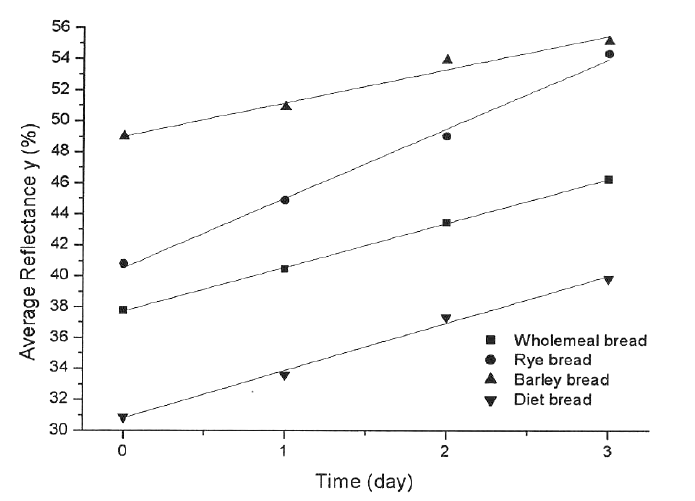
Figure 2. Experimental and calculated average reflectance